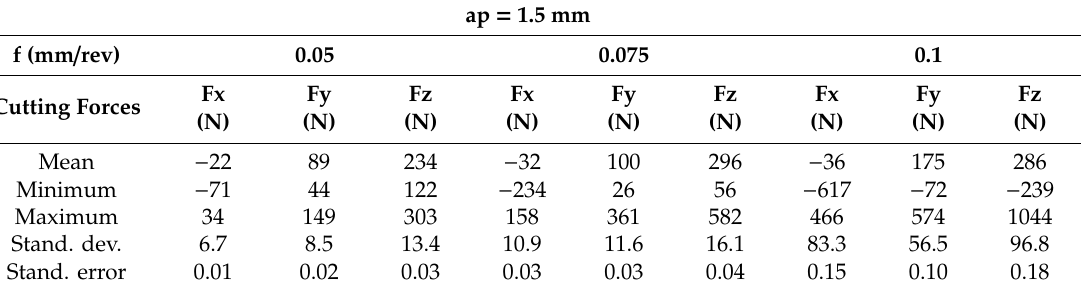
Table 4. Statistical analysis of cutting forces for ap = 1.5 mm.